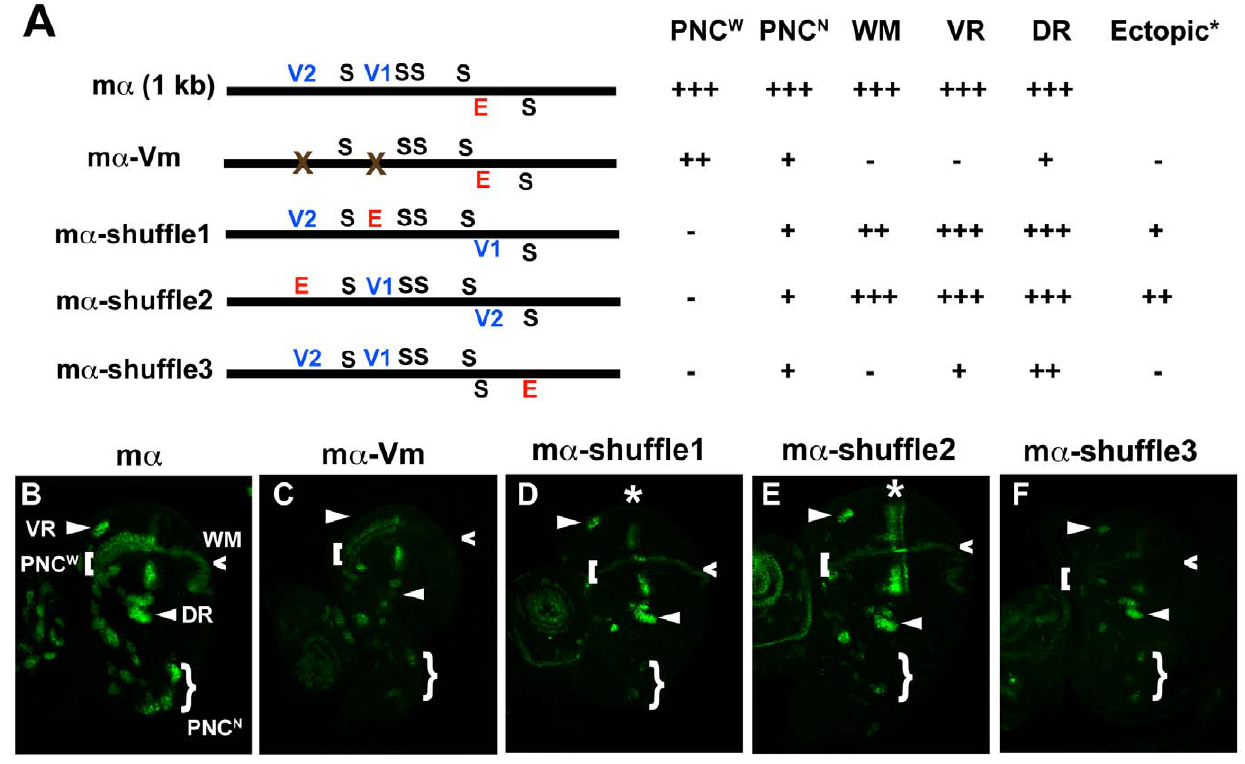
Figure 4. Rearranging required transcription factor binding motifs in the m a enhancer strongly affects its activity. (A) Diagrams of the wild-type m a enhancer and variants. The module’s five Su(H) sites (S) are shown in black; the lone ‘‘E box’’ proneural protein binding site (E) is in red; the two Vvl (POU-HD/homeodomain) sites (V1, V2) are in blue. m a -Vm has both Vvl sites mutated, while the m a -shuffle constructs respectively exchange the position of the E motif with those of the V1, V2, and S 1 sites [11]. Observed patterns and levels of GFP expression driven by each variant are summarized at right. Symbols are as follows (see B): PNC W , proneural clusters flanking the anterior wing margin primordium; PNC N , proneural clusters of the notum region; WM, wing margin primordium; VR, ventral radius proneural cluster; DR, dorsal radius proneural cluster. (B–F) GFP reporter expression in wing imaginal discs of late third-instar larvae. Among other effects, mutating the Vvl motifs in the enhancer (m a -Vm) eliminates or severely reduces its activity in VR, WM, DR, and PNC N (B, C). Exchanging the position of the E motif with that of either the V1 or V2 site (m a -shuffle1 and m a -shuffle2) severely reduces activity in many PNCs, while also yielding ectopic activity in a stripe within the wing pouch region (asterisk) (B, D–E). Exchanging the positions of the E and S 1 sites (m a -shuffle3) essentially eliminates PNC W and WM activity, while greatly reducing activity in other proneural clusters (B, F).